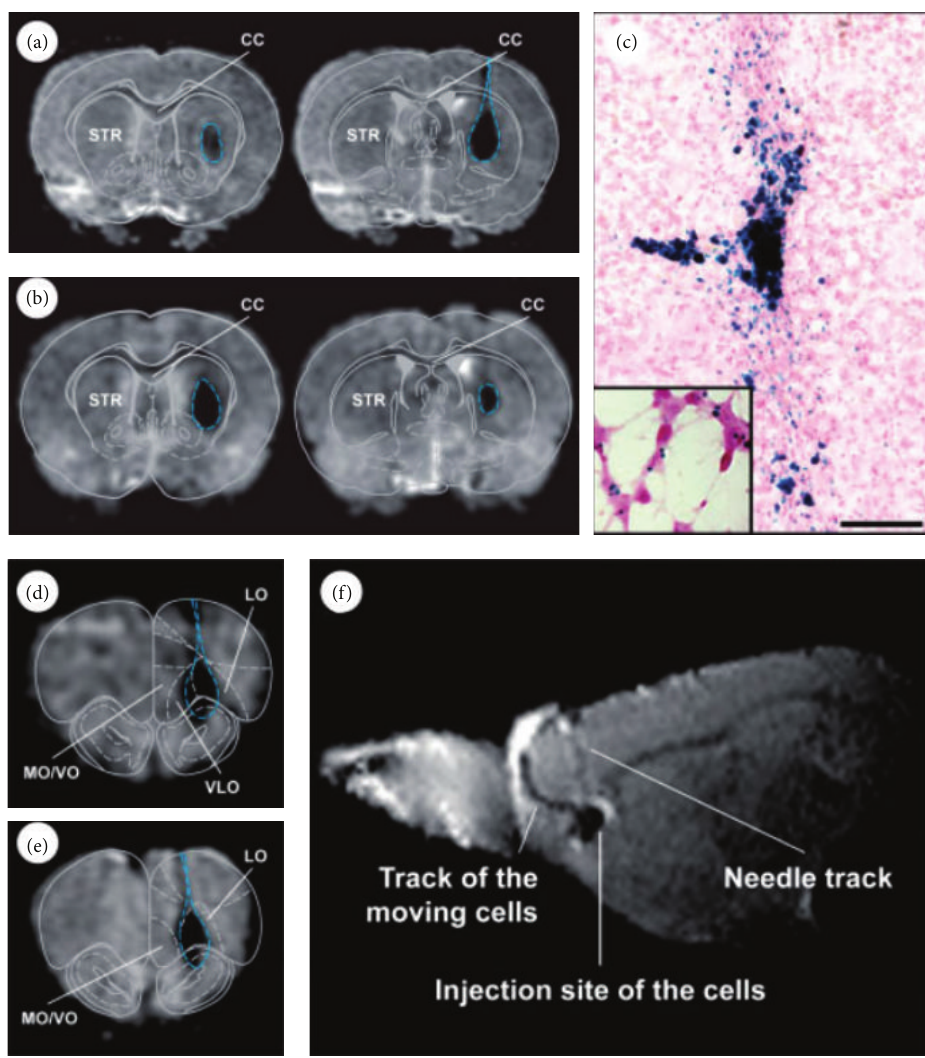
Figure 3: Longitudinal MRI studies of transplanted SVZ cells. T2-weighted MRI studies of transplanted SVZ cells 2 h after transplantation into the striatum (a) and 21 days later (b). Images were acquired with a 9.4 T machine. The needle track and cell transplant have been arbitrarily delineated by a dotted blue line. The schematic atlas drawings have been overlaid onto MRI images to facilitate anatomical localization of the graft site (see methods for overlay procedure). (c) Prussian blue staining of the rat striatum depicts distribution of transplanted, iron oxide- labeled SVZ cells one month after transplantation. Iron deposits stain blue with potassium ferrocyanide. Cells are also counterstained with pararosaniline allowing the cytoplasm to appear as light pink also depicted in cells in vitro (see inset (c)). Further MRI of SVZ cells into the RMS confirmed correct positioning of the graft immediately after the transplantation procedures (d) and normal localization and growth 14 days after transplantation (e). (f) A sagittal T2-weighted MR image shows the migration of SPIO-labeled SVZ cells towards the olfactory bulb 7 days after transplantation. STR, striatum; CC, corpus callosum; LO, lateral orbital cortex; VLO, ventrolateral orbital cortex; MO/VO, medial orbital cortex/ventral orbital cortex